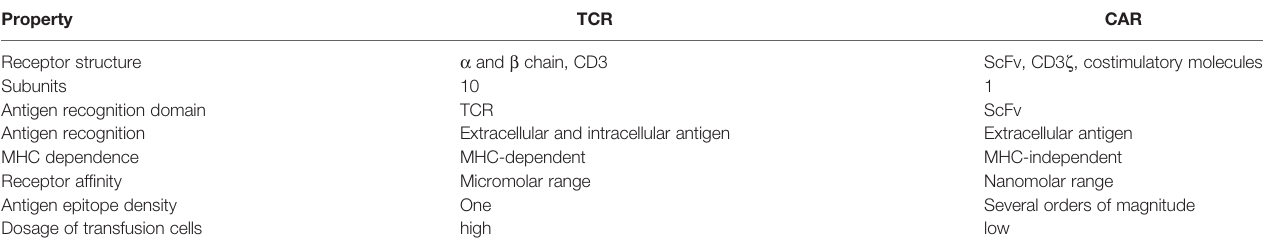
TABLE 2 | Comparison of structural features and mechanisms of TCRs versus CARs in cancer immunotherapy.